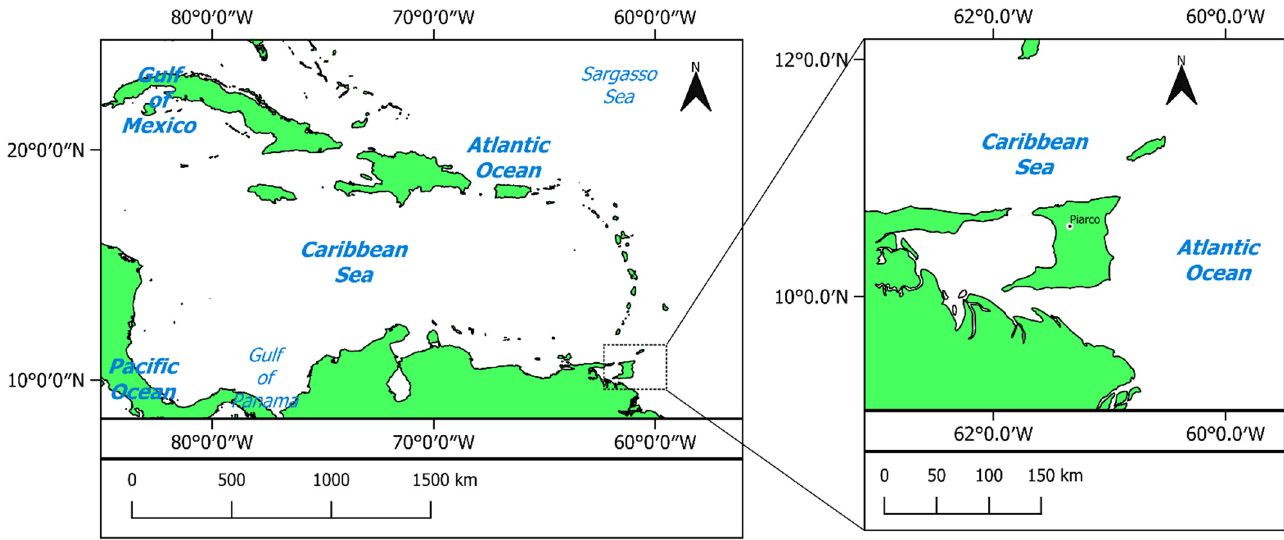
Figure 2. Map of the Republic of Trinidad and Tobago [130,131].